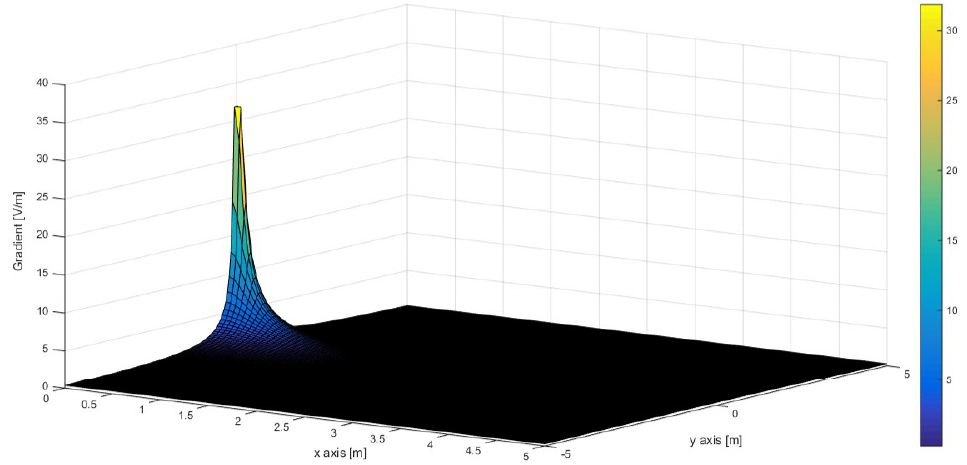
Figure 18. Electric field strength for method “C”, of linear current source, for the area of Korakia ( ρ S = ∞ , without dam, L = 1.1815 m, ρ w = 0.25 Ω · m, θ = 248 ◦ , J maintenance_steady = 22 A/m 2